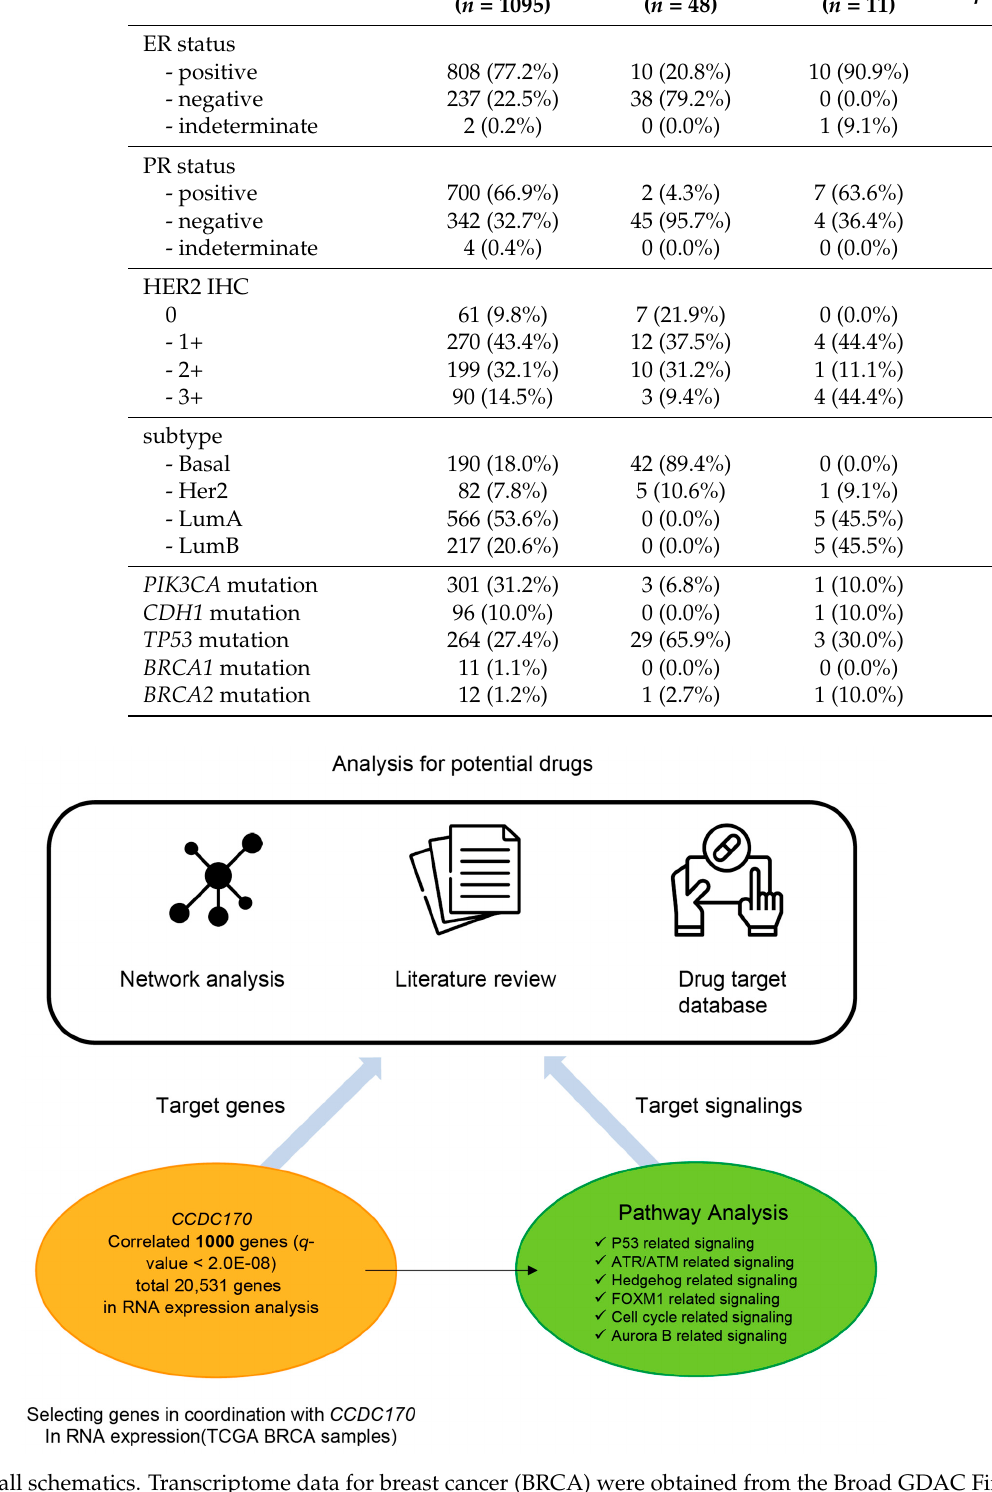
Figure 1. Overall schematics. Transcriptome data for breast cancer (BRCA) were obtained from the Broad GDAC Firehose database. Following the RNA measurement analysis of a total of 20,531 genes, 1000 genes correlated with CCDC170 were selected ( q < 2.0 × 10 − 8 ). Over-representation analysis of the 1000 genes demonstrated a significant relationship with six major cancer-related pathways (p53, ATR/ARM, hedgehog, FOXM1, cell cycle, and Aurora B). Potential gene targets and drug candidates were isolated via drug network analysis using a drug-target database on genes correlated to CCDC170 and the literature review.